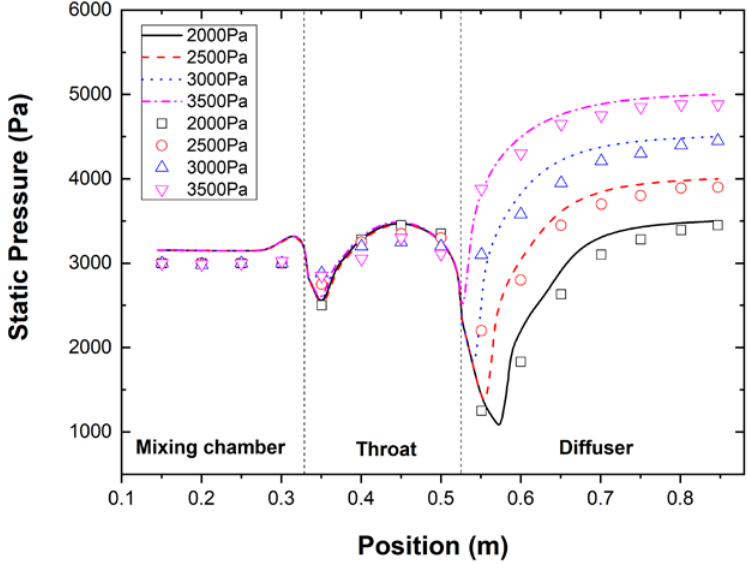
Figure 4. Wall pressure distribution under different back pressure.